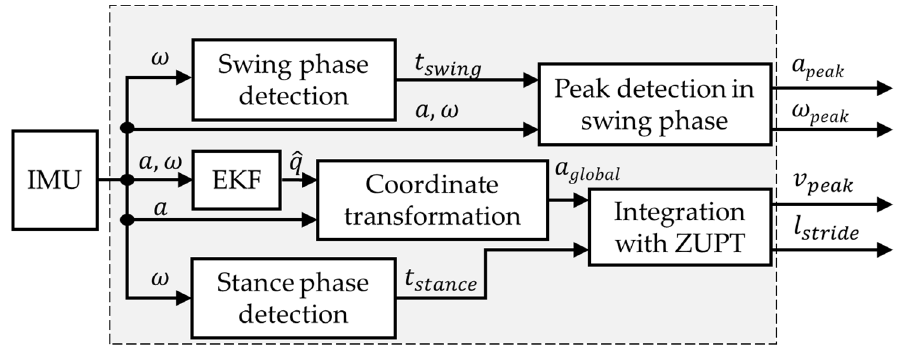
Figure 8. The calculation algorithm of gait parameters.